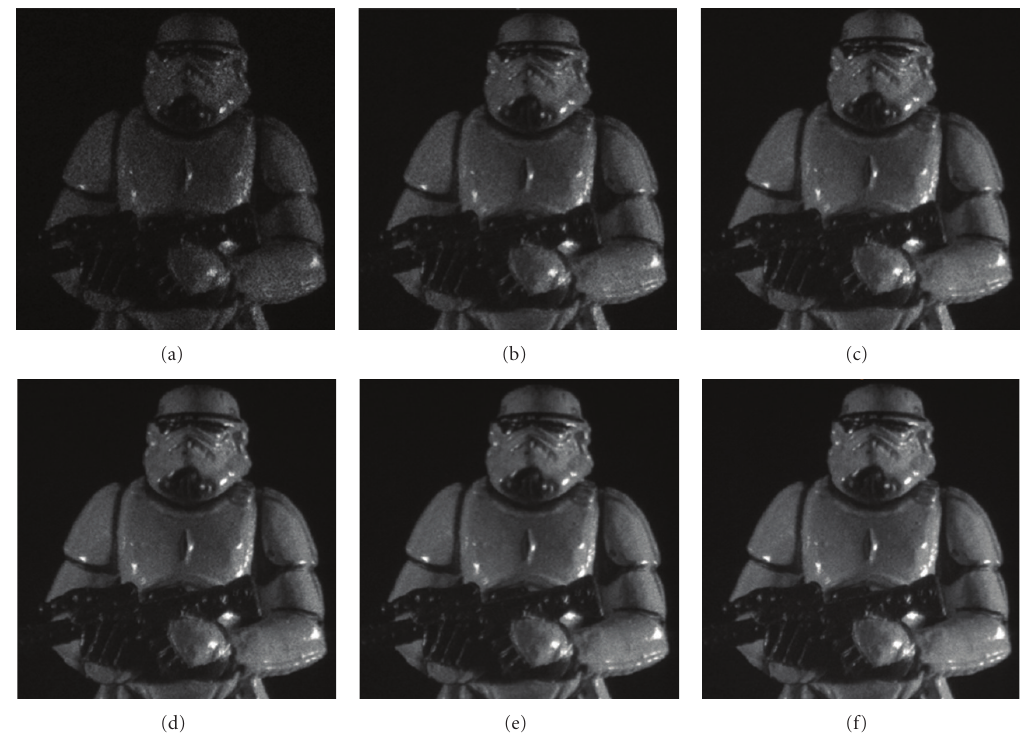
Figure 9: Removal of speckle noise by adding multiple reconstructed digital hologram captures together on an intensity basis. For each capture a di ff erent di ff use and random field is used to illuminate our object. (a) One image, (b) Sum of 3 intensities, (c) Sum of 5 intensities, (d) Sum of 7 intensities, (e) Sum of 10 intensities, (f) Sum of 14